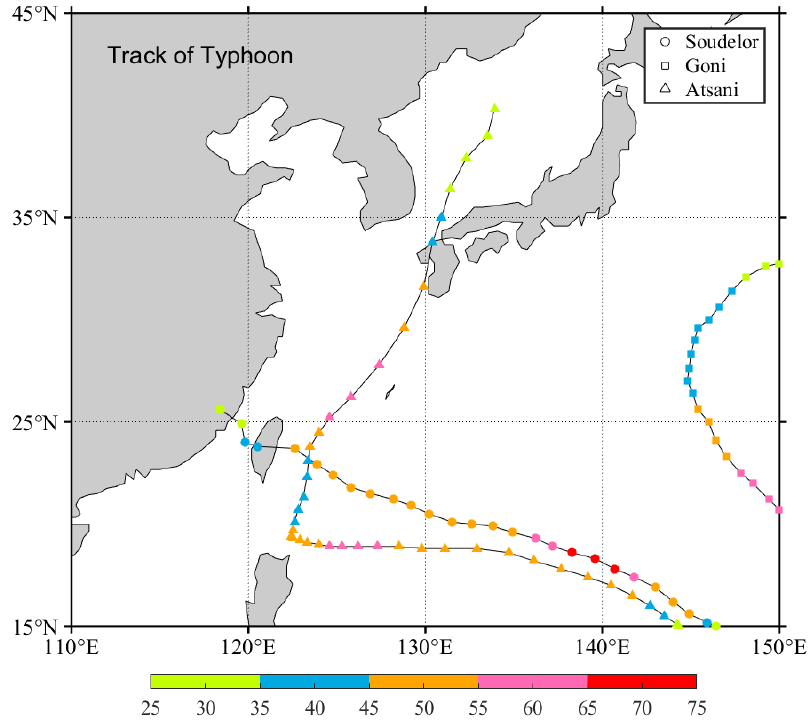
Figure 2. Typhoon track map for August in the study area (wind speed, colored shading; m/s). The circle represents Typhoon Soudelor (1–8 August, max radius of over 24 m/s winds 180 km), the square represents Goni (15–26 August, max radius of over 24 m/s winds 220 km), the triangle represents Atsani (16–26 August, max radius of over 24 m/s winds 240 km).